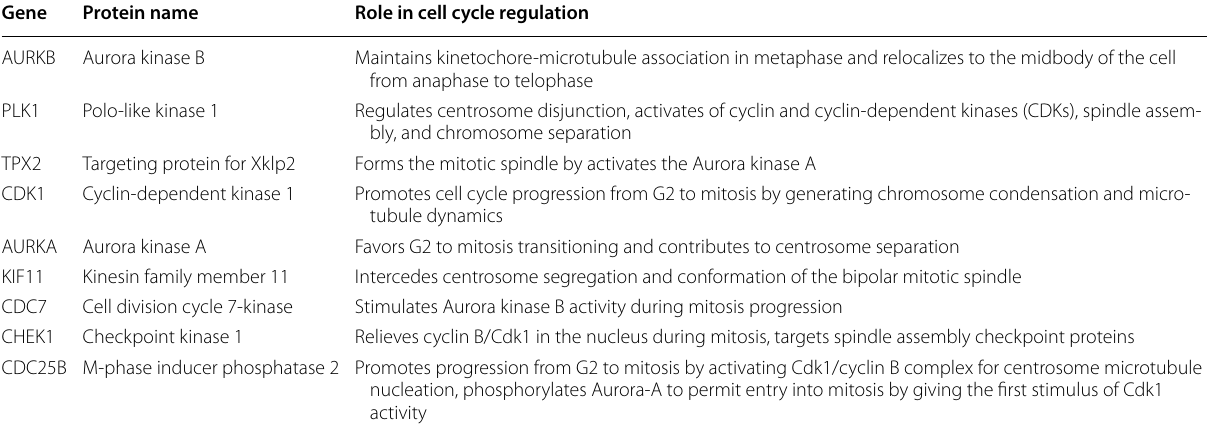
Table 1 The CPTGs which involved in the G2/M checkpoint hallmark according to